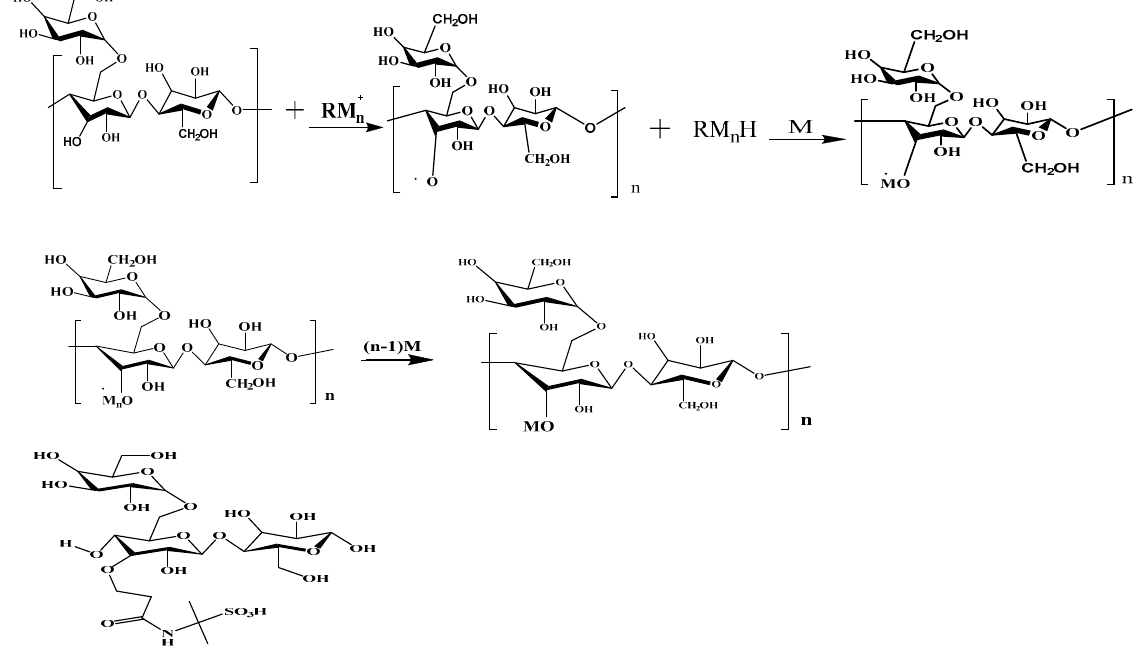
Figure 1. Molecular structure and synthesis scheme of guar gum grafted 2-acrylamido-2- methylpropanesulfonic (GG-AMPS). M = AMPS.